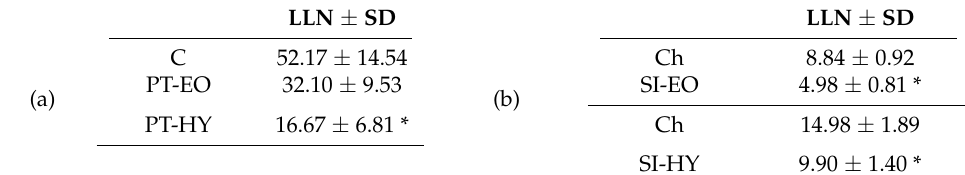
Figure 6. Antiphytoviral activity of P. ramosissima against tobacco mosaic virus infection on local host plants. ( a ) Pretreatment of plants with essential oil (EO) or hydrosol (HY). ( b ) Simultaneous inoculation of EO or HY with virus. * statistically significant differences between essential oil and hydrosol treatment data ( p < 0.05). Table 4. Number of local lesions on: (a) leaves of local host plants treated with essential oil and hydrosol before virus inoculation; (b) leaf halves simultaneously inoculated with virus and essential oil or